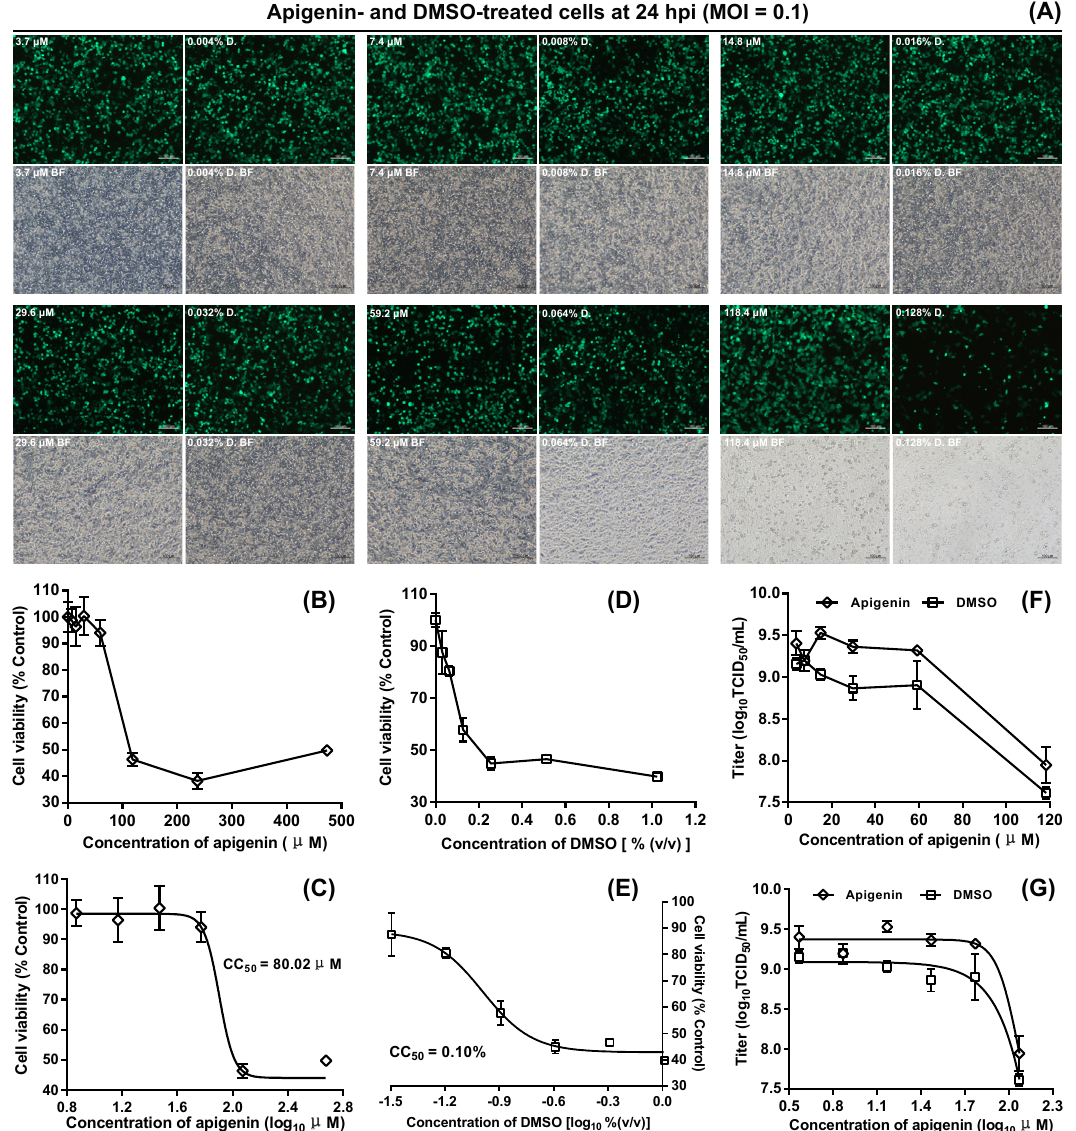
Figure 6. Anti-rSVA-eGFP assay of apigenin in vitro. Apigenin- and DMSO-treated cell monolayers at di ff erent concentrations at 24 hpi ( A ). Each cell monolayer is observed in a randomly selected field-of-view of fluorescent microscope. D: DMSO control. Relative viability of BSR cells at 24 h after either apigenin ( B ) or DMSO ( D ) treatment at di ff erent concentrations by MTT assay. The data represent the mean ± SD for five replicates per dilution. The CC 50 value either for apigenin ( C ) or for DMSO ( E ), calculated by nonlinear regression fitting using the GraphPad Prism software. Variations in rSVA-eGFP titers at 24 h after either apigenin or DMSO treatment at di ff erent concentrations ( F ). The data represent the mean ± SD for three independent experiments. The data in ( F ) are processed by nonlinear regression fitting using the GraphPad Prism software, and then shown in ( G